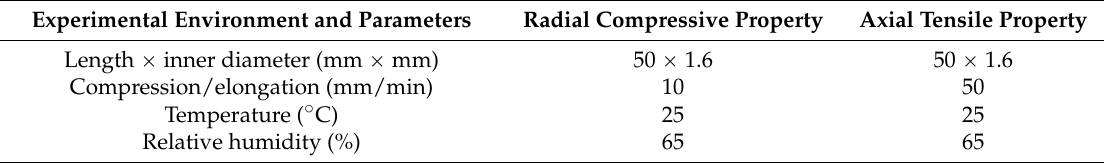
Table 2. Experimental environment and parameters.